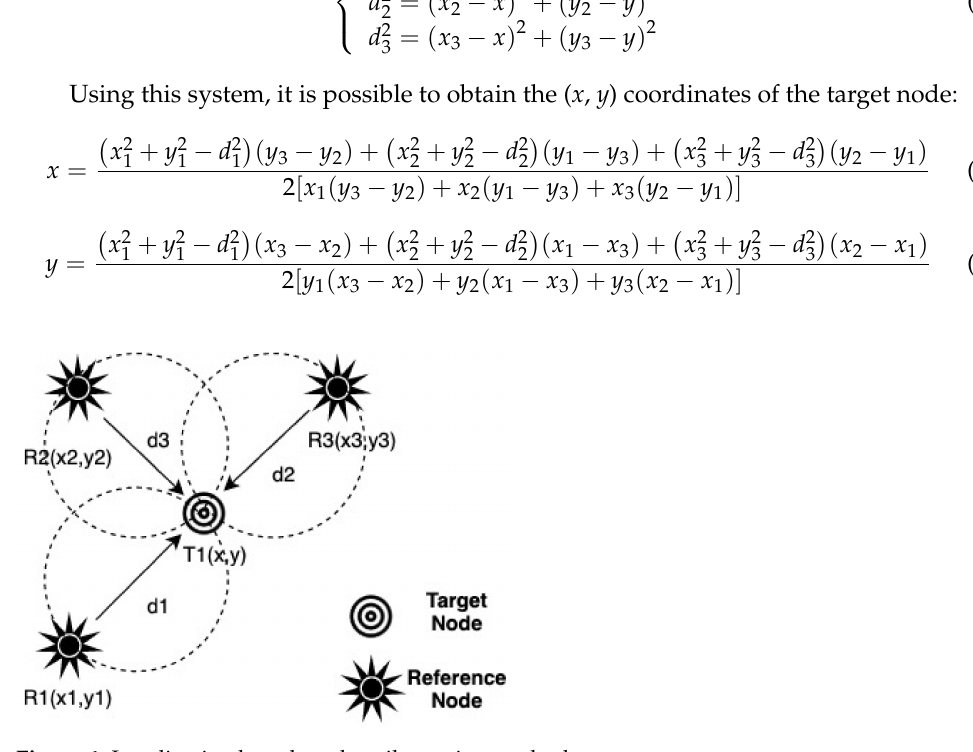
Figure 4. Localization based on the trilateration